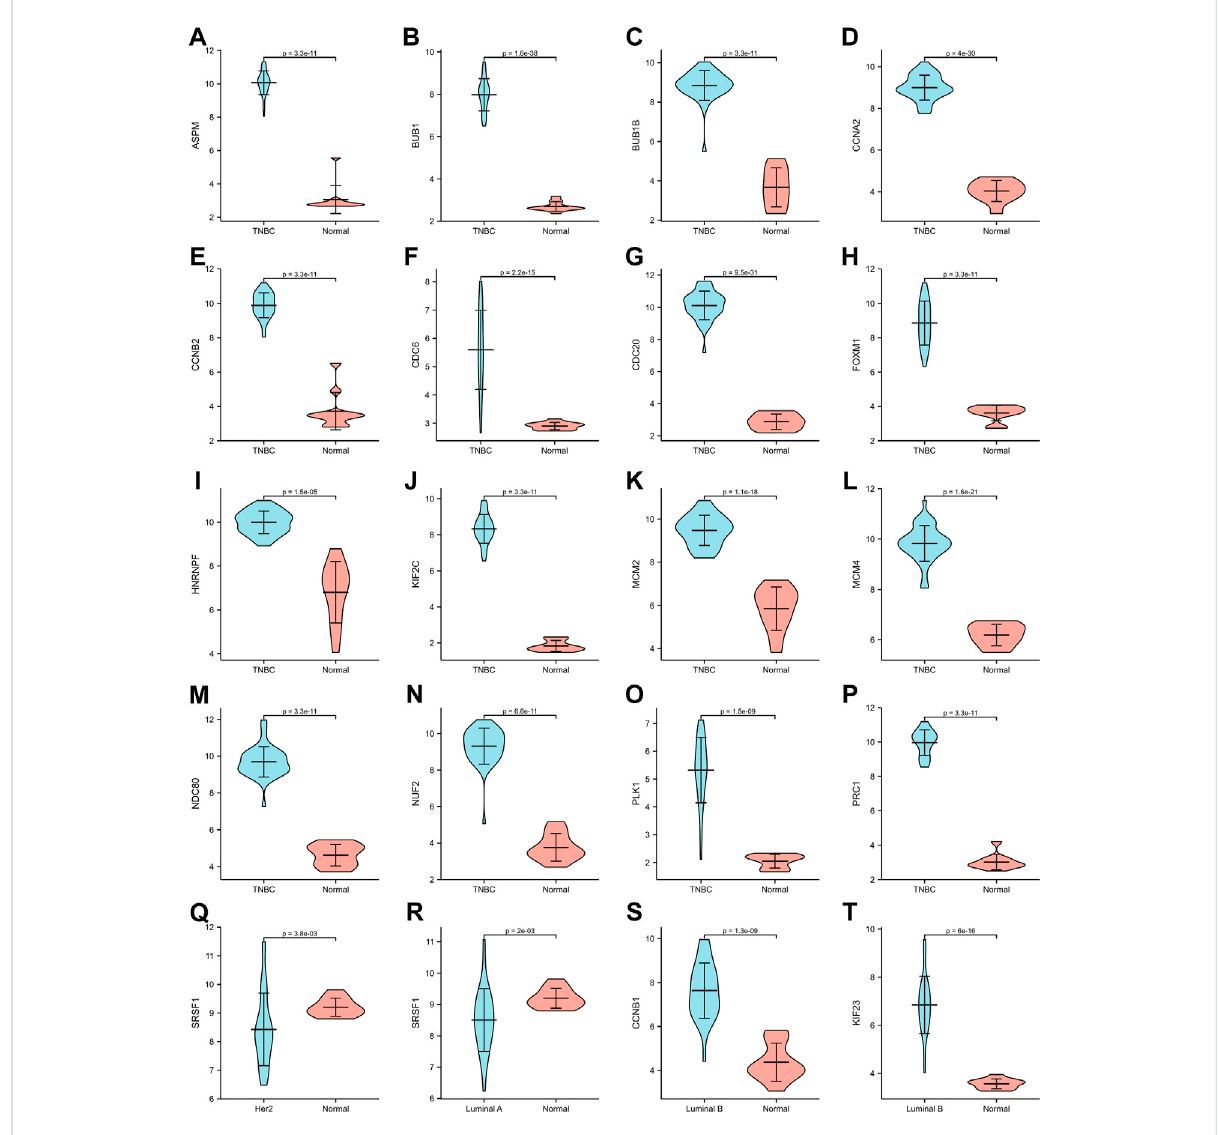
FIGURE 6 Expression of hub genes in GSE45827. (A – P) ASPM , BUB1 , BUB1B , CCNA2 , CCNB2 , CDC6 , CDC20 , FOXM1 , HNRNPF , KIF2C , MCM2 , MCM4 , NDC80 , NUF2 , PLK1 , PRC1 expression in TNBC subtype. (Q) SRSF1 expression in Her2 subtype. (R) SRSF1 expression in Luminal A subtype. (S,T) CCNB1, KIF 23 expression in Luminal B